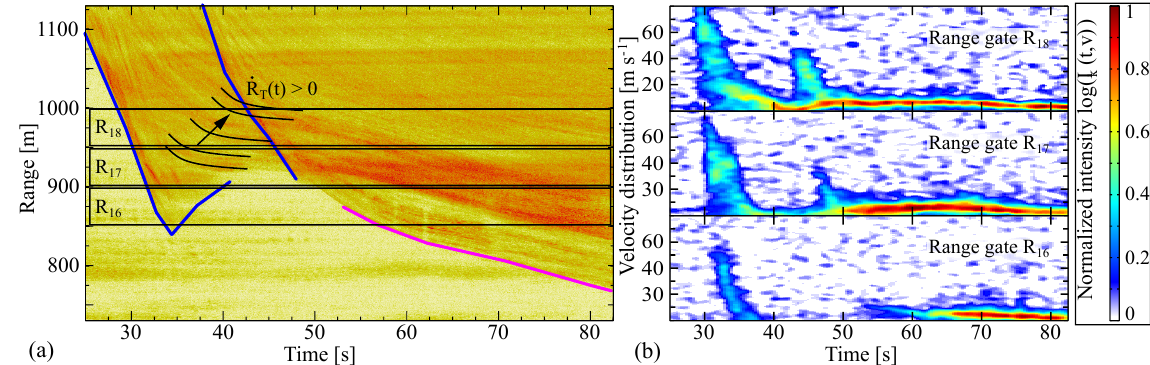
Figure 4. A detailed look of the complete transition from bottom panels of Fig. 2. (a) MTI with location of Doppler range gates. The location of transition R T is not fixed but moves upward with time ˙ R T (t) > 0. (b) Doppler velocity distribution in range gates R 16 (850–900m), R 17 (900–950m) and R 18